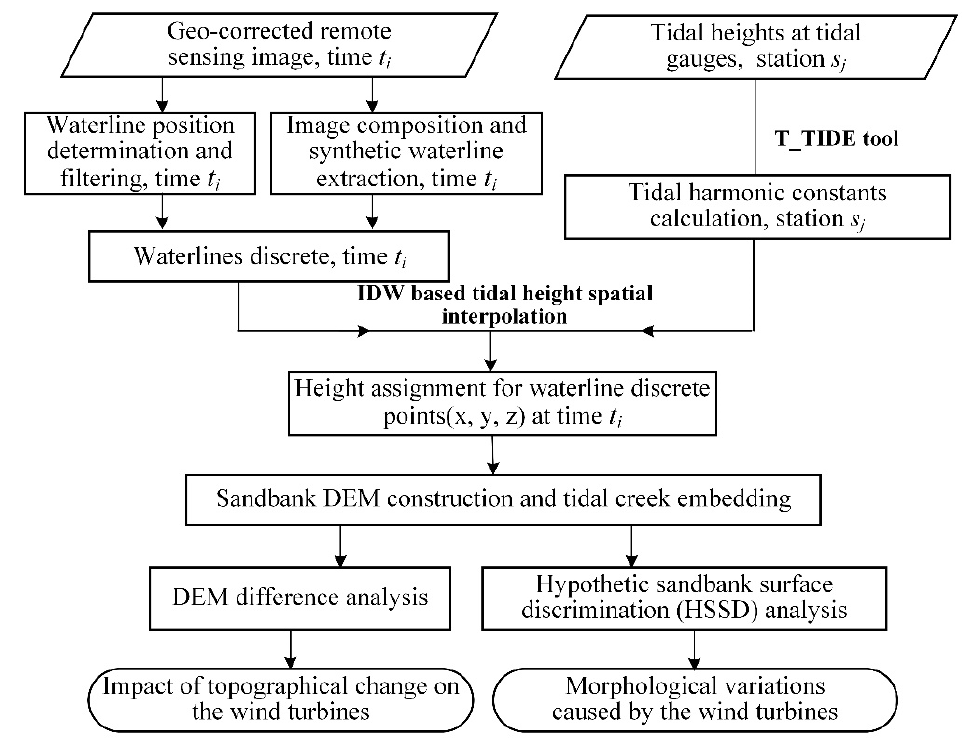
Figure 3. Flow diagram of the proposed methodology adopted in the